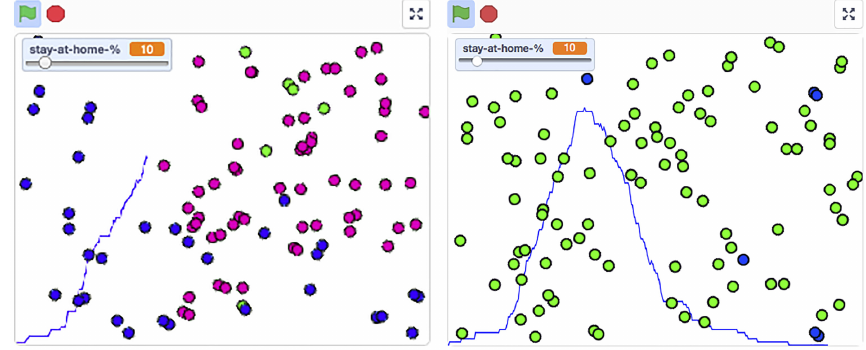
Figure 4. Epidemic simulation